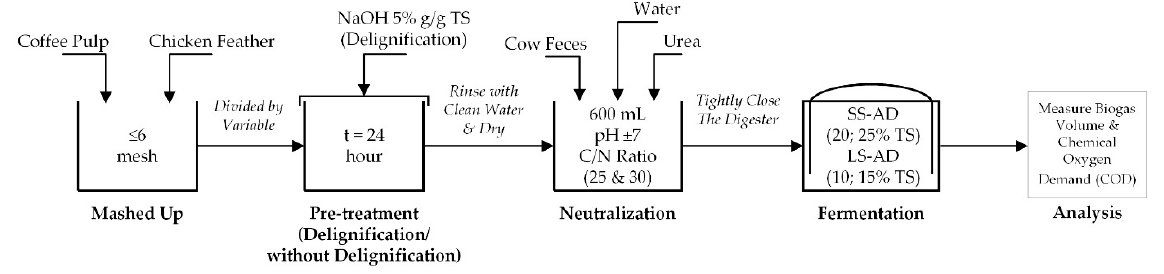
Figure 1. Scheme of the biogas production process.